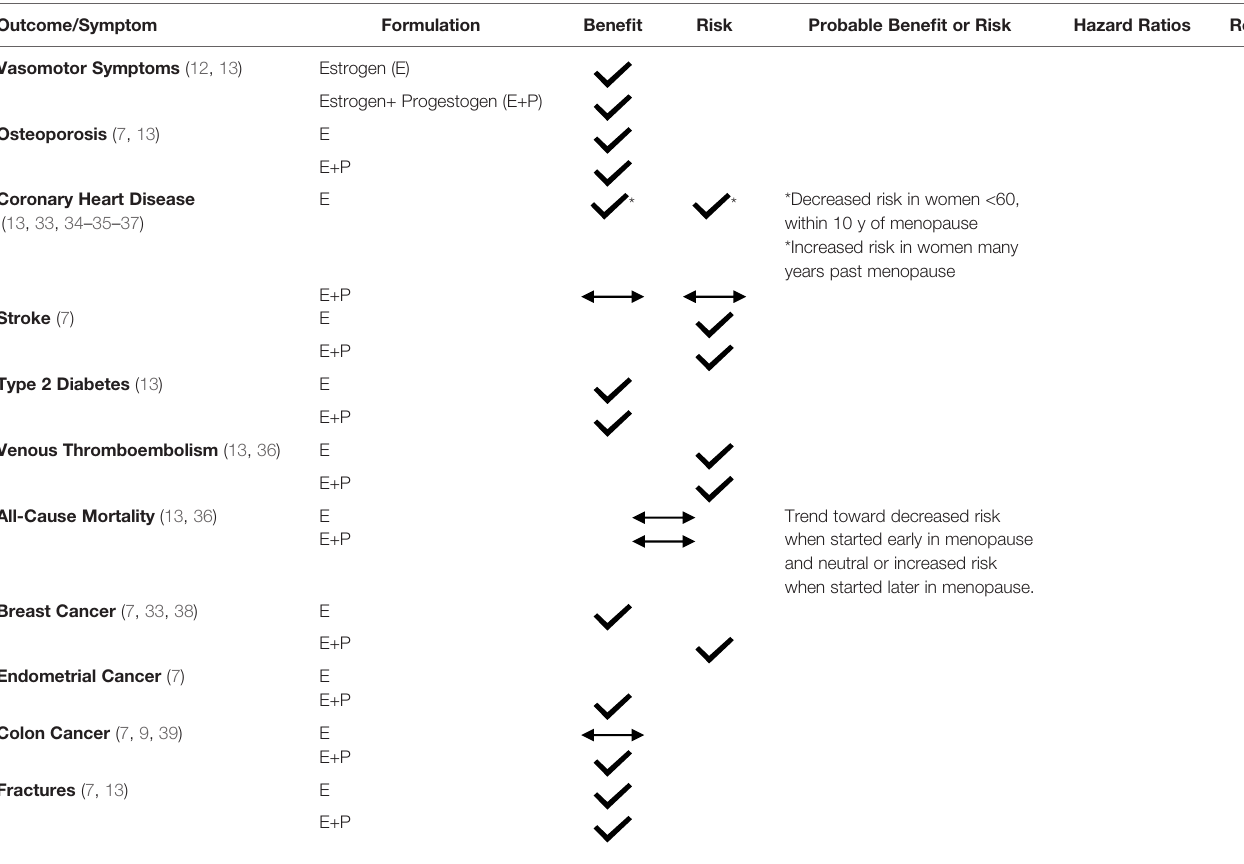
TABLE 3 | Risk-bene fi t pro fi le of menopausal hormone therapy. Outcome/Symptom Formulation Bene fi t Risk Probable Bene fi t or Risk Hazard Ratios